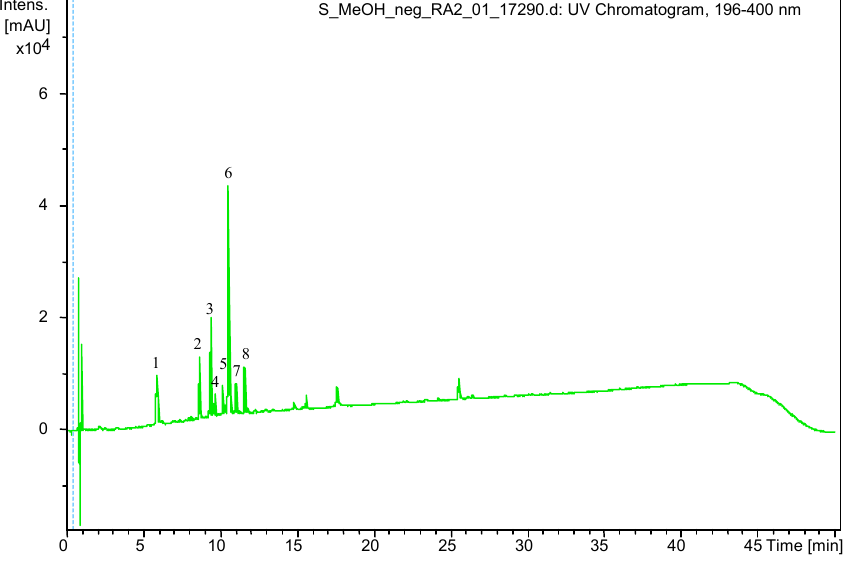
Figure 1. UHPLC-DAD chromatogram of the methanol extract of S. virgaurea obtained at 196–400 nm. Table 1. Tentative assignment of UHPLC chromatogram main peaks as phenolic compounds, based on MS. Peak Number.